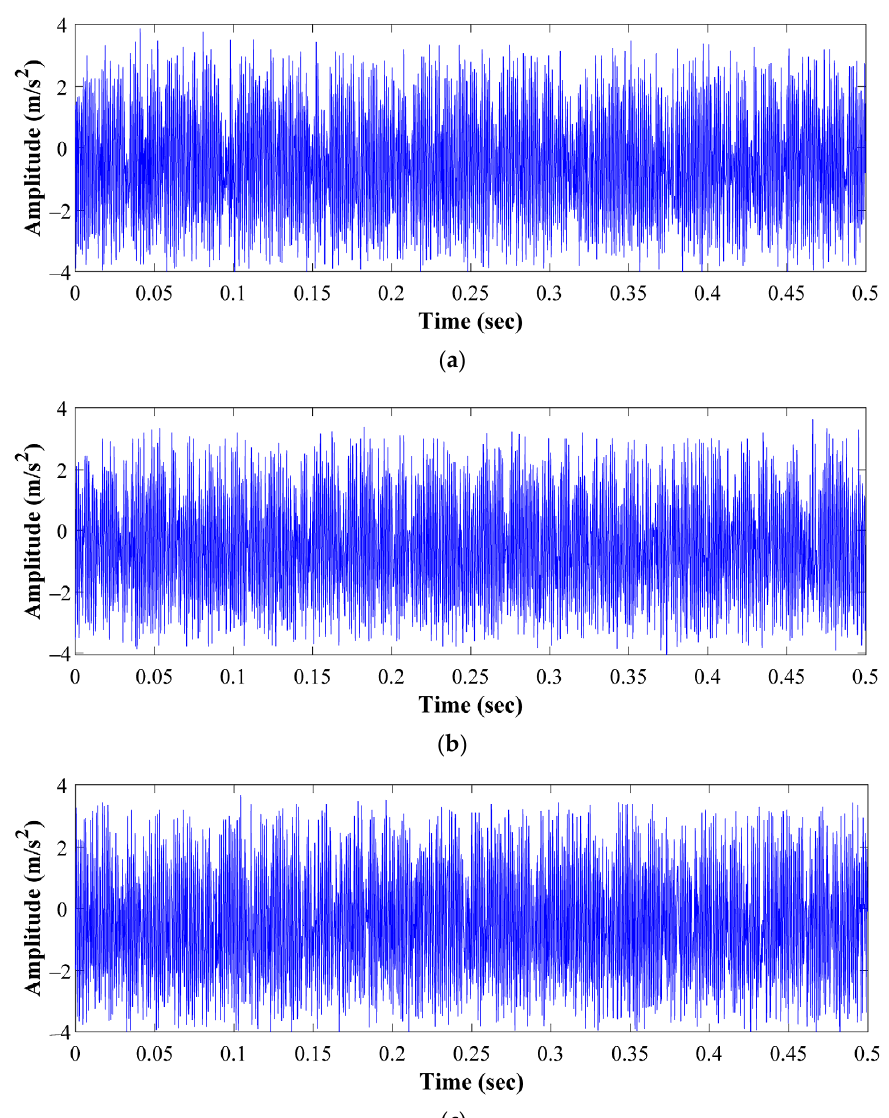
Figure 5. Set of damaged bearing used to be experimentally tested in the IM of an electromechani- cal system: ( a ) metallic damaged bearing, ( b ) hybrid damaged bearing and ( c ) full ceramic dam- aged bearing.